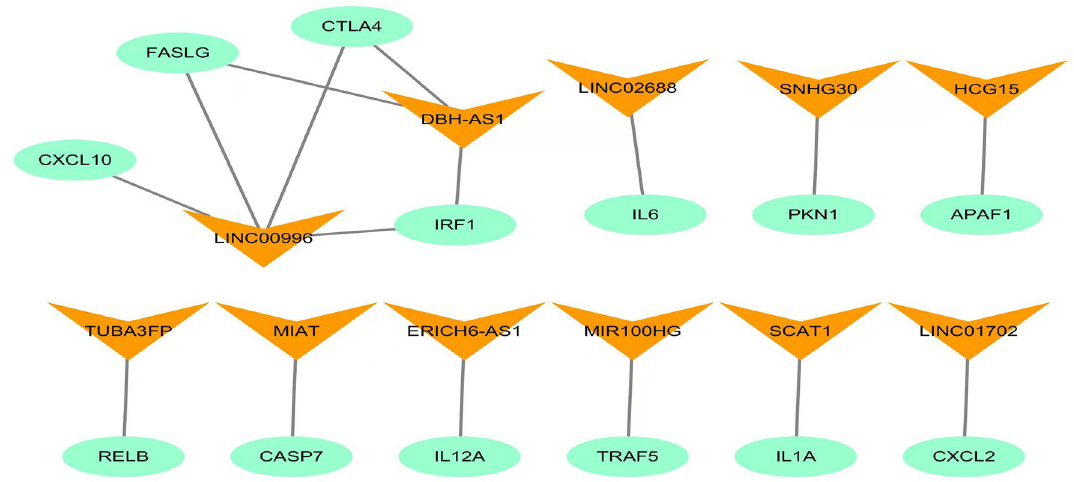
Figure 4. Construction of the necroptosis-related lncRNA-mRNA co-expression network ( A ) Diagram of the necroptosis-related lncRNA-mRNA network.